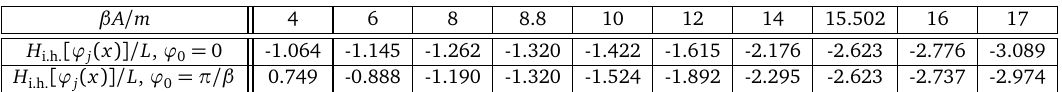
Table 4.2: Energies of the two configurations ϕ m σ = 2 / 3 and (cid:96) = mL =